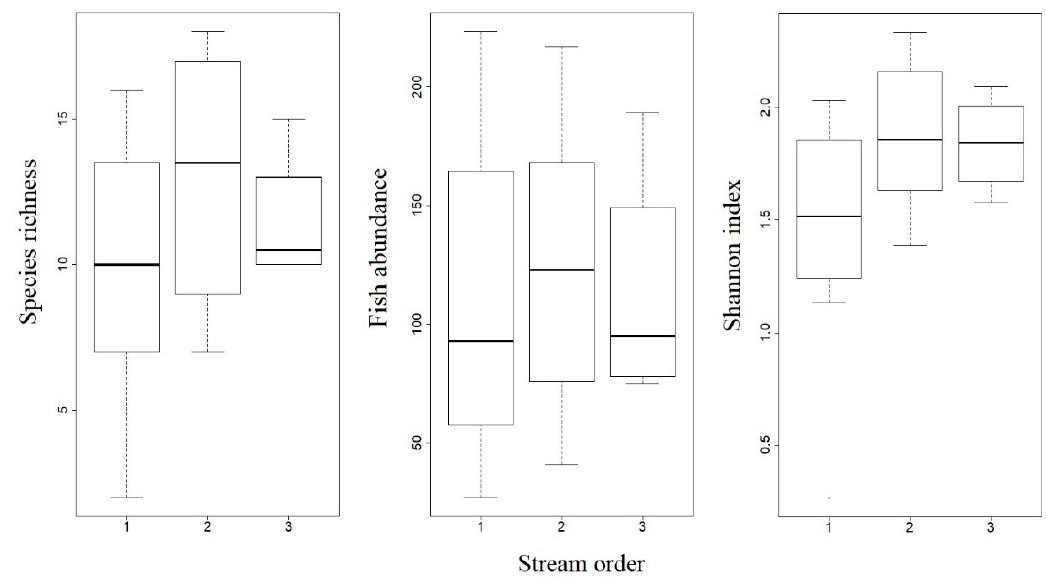
Figure 6. Species richness, fish abundance, and Shannon index in different stream orders in upstream Lijiang River.